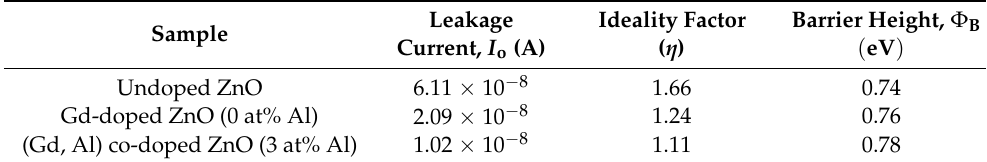
Figure 8. I-V measurements of the n-ZnO-based DMS/p-Si heterojunction. Table 5. The electrical characteristics of n-ZnO-based DMS/p-Si heterojunction derived from I-V measurements.